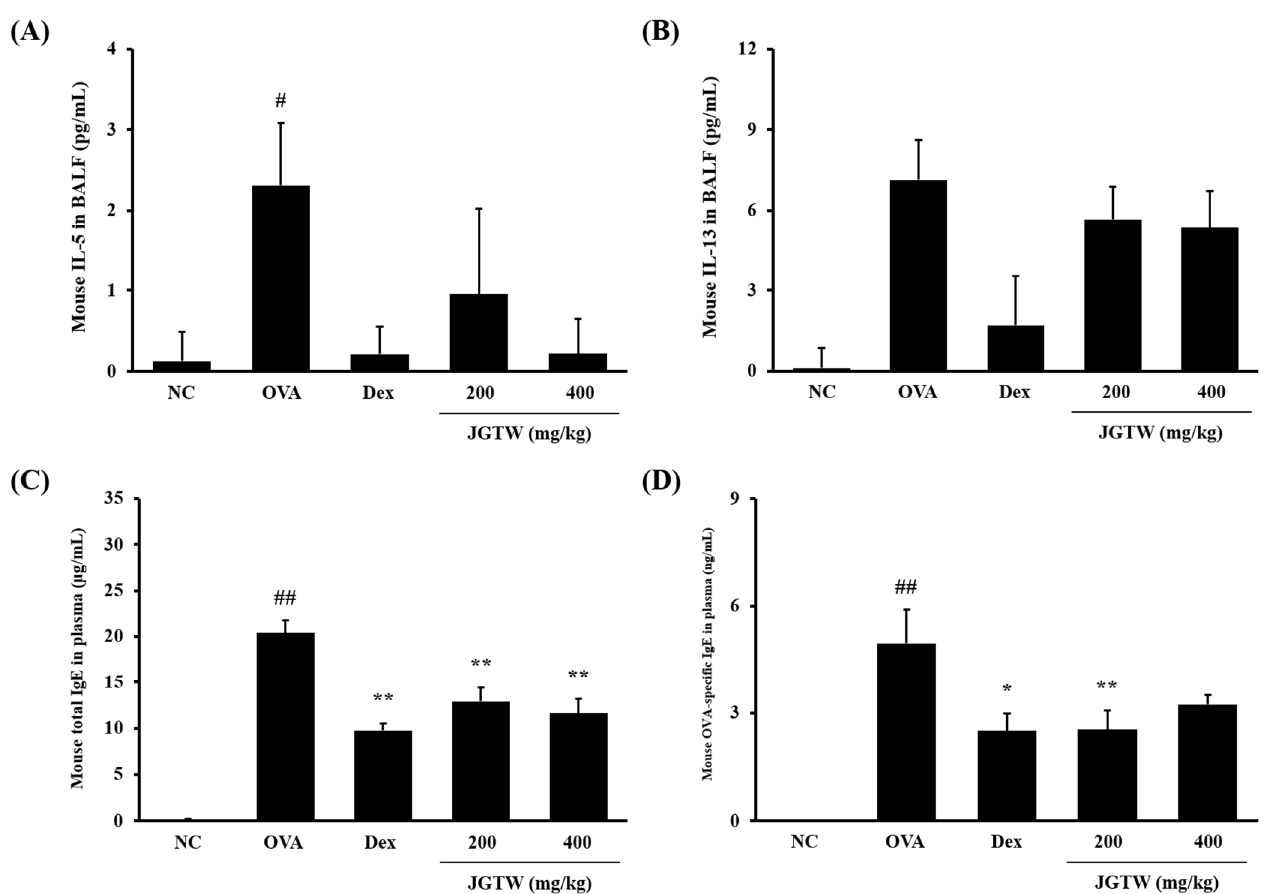
Figure 9. Effect of JGTW on Th2 cytokines and IgE levels in OVA-induced mice. The levels of Th2 cytokines and IgE were determined by ELISA kits. Th2 cytokines: IL-5 ( A ) and IL-13 ( B ). IgE: total IgE ( C ) and OVA-specific IgE ( D ). The values are presented as mean ± SEM. # p < 0.05 or ## p < 0.01 versus NC group; and * p < 0.05 or ** p < 0.01 versus OVA-induced group.